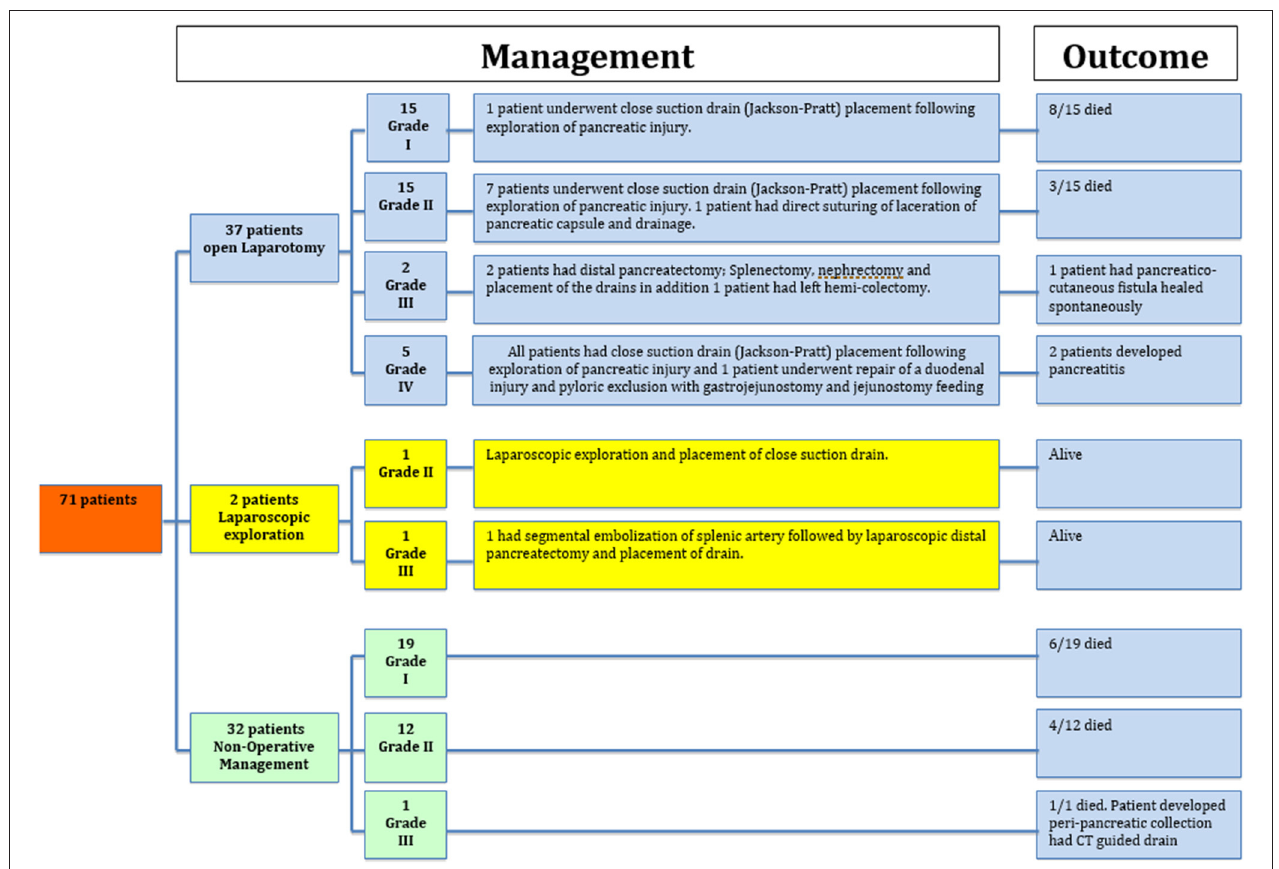
FIGURE 3 | Management and outcomes based on the pancreatic injury